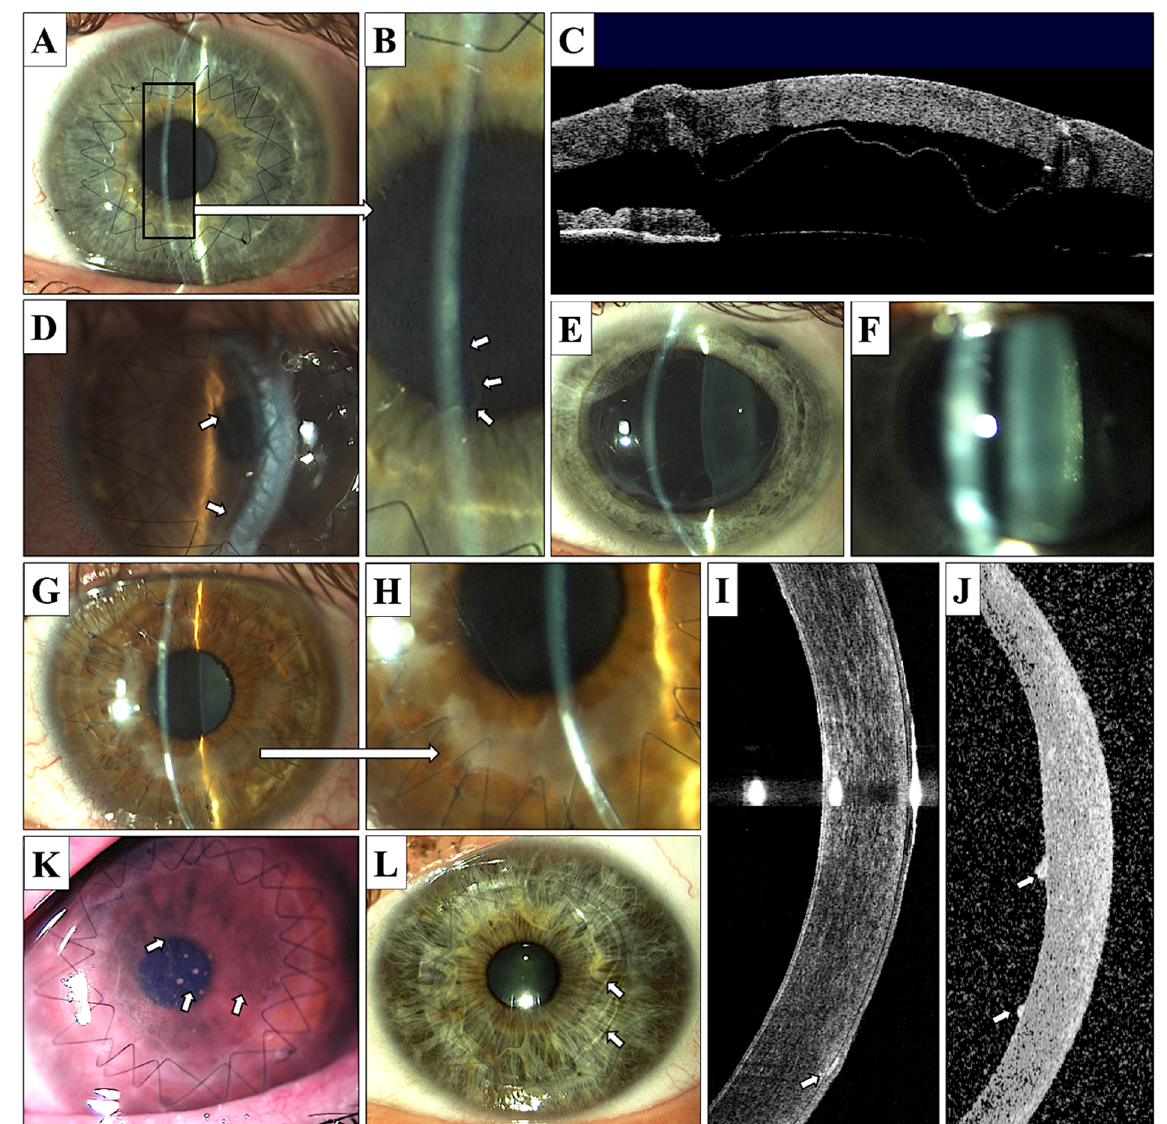
Figure 3. Postoperative complications of DALK and PK surgery. ( A–D ) — DALK, Descemet’s membrane detachment; (A) — localized, mild detachment (magnification presented on photograph B, arrows), ( C ) — severe Descemet’s membrane detachment visualized in anterior OCT (Visante); ( D ) — severe Descemet’s membrane detachment causing corneal graft edema (arrows). ( E ) — PK, Urrets – Zavalia syndrome; ( F ) — PK, posterior subcapsular cataract formation; ( G–I ) — DALK, subepithelial opacifications (( G , H ) — opacifications visible in area of sutures, mostly in the lower cornea; ( I ) — anterior OCT Visante, subepithelial opacifications visible in lower cornea, arrow); ( J ) — PK, anterior OCT Visante, endothelial sediments associated with endothelial graft disease; ( K ) — PK, endothelial graft disease with visible Khodadoust line (arrows) and endothelial sediments; and ( L ) — PK, Descemet’s membrane folds (arrows).